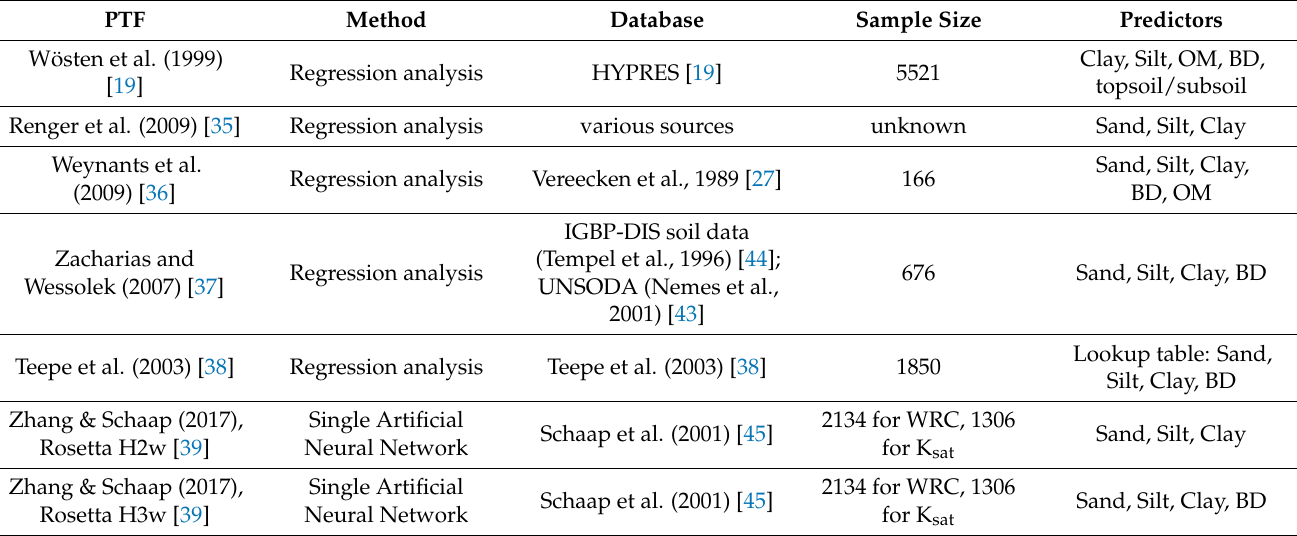
Table 4. Overview of the selected PTFs including their main